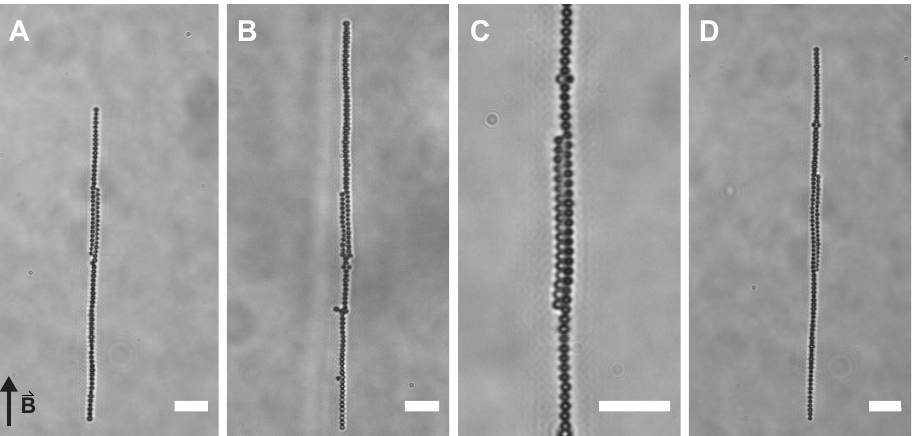
Figure 3. Linear sphere chains. In a homogeneous magnetic field of 3mT, linear sphere chains are formed for all studied concentrations of PEO. ( A ) 0mg/mL, ( B ) 0.10mg/mL, ( C ) 0.14mg/mL and ( D ) 0.16mg/mL PEO. Scale bars are 5 µ m. All images were taken approximately one hour after switching the magnetic field on. The arrow indicates the direction of the applied field in all images.